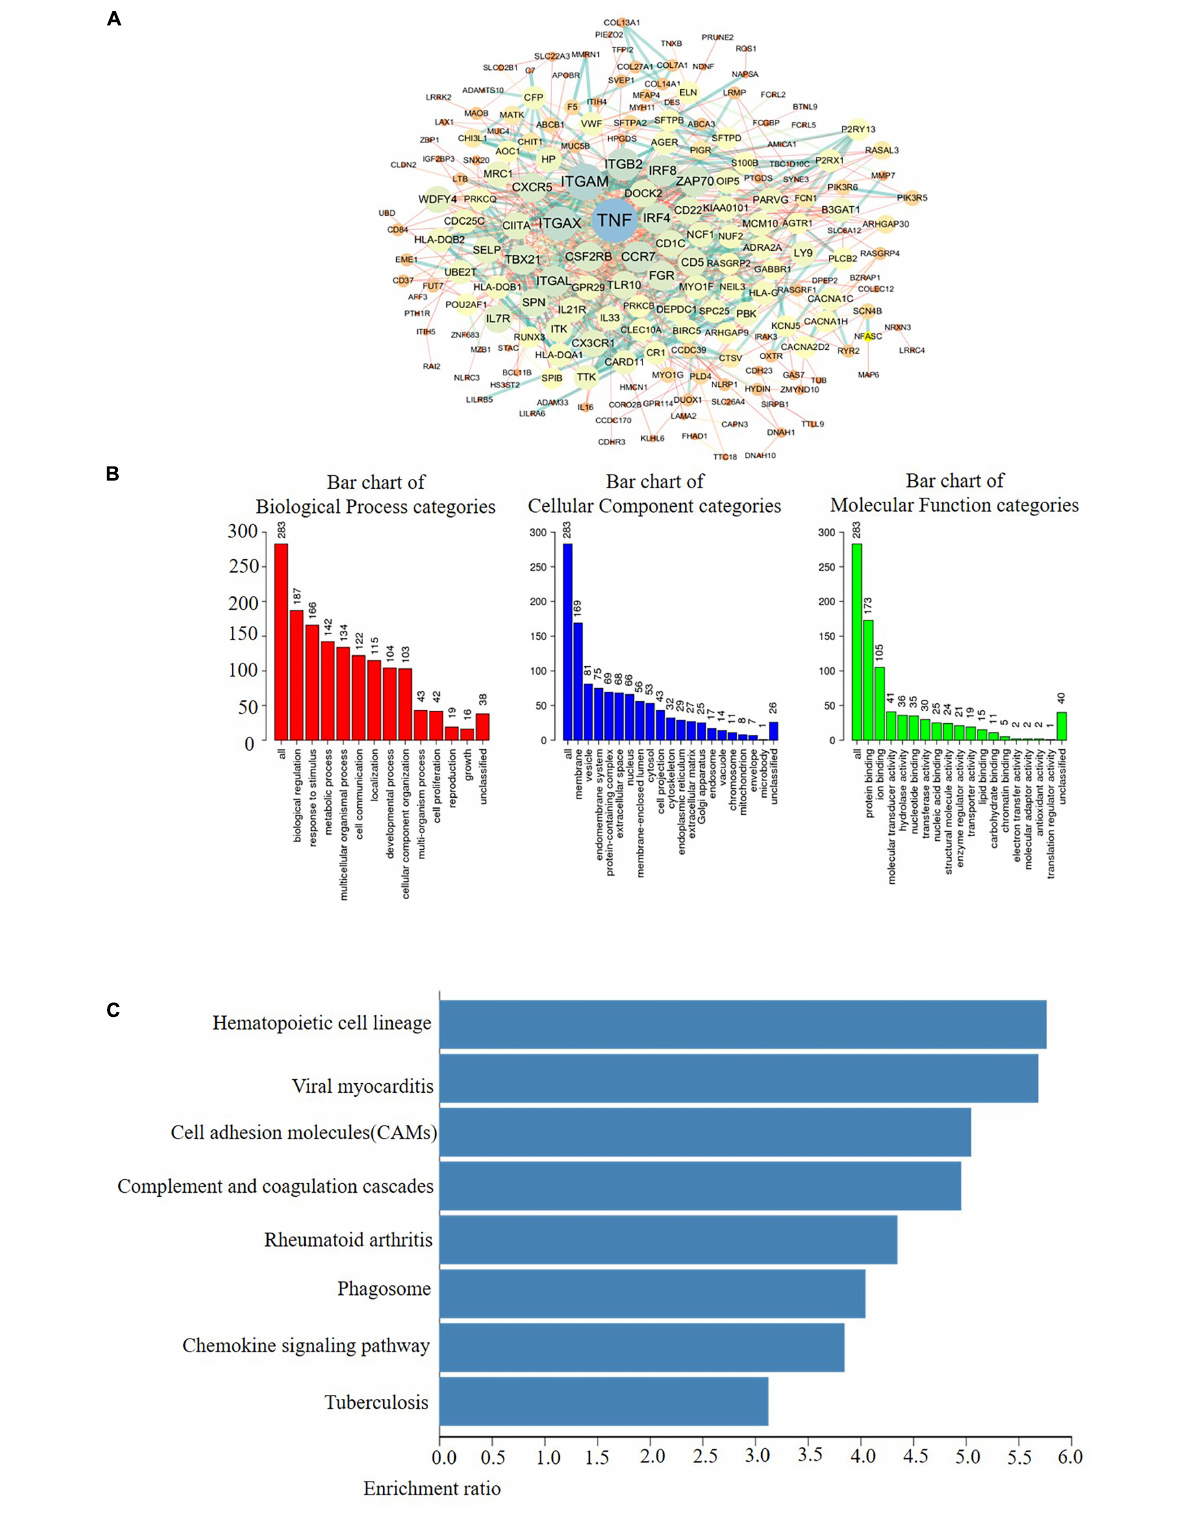
Frontiers in Cell and Developmental Biology |